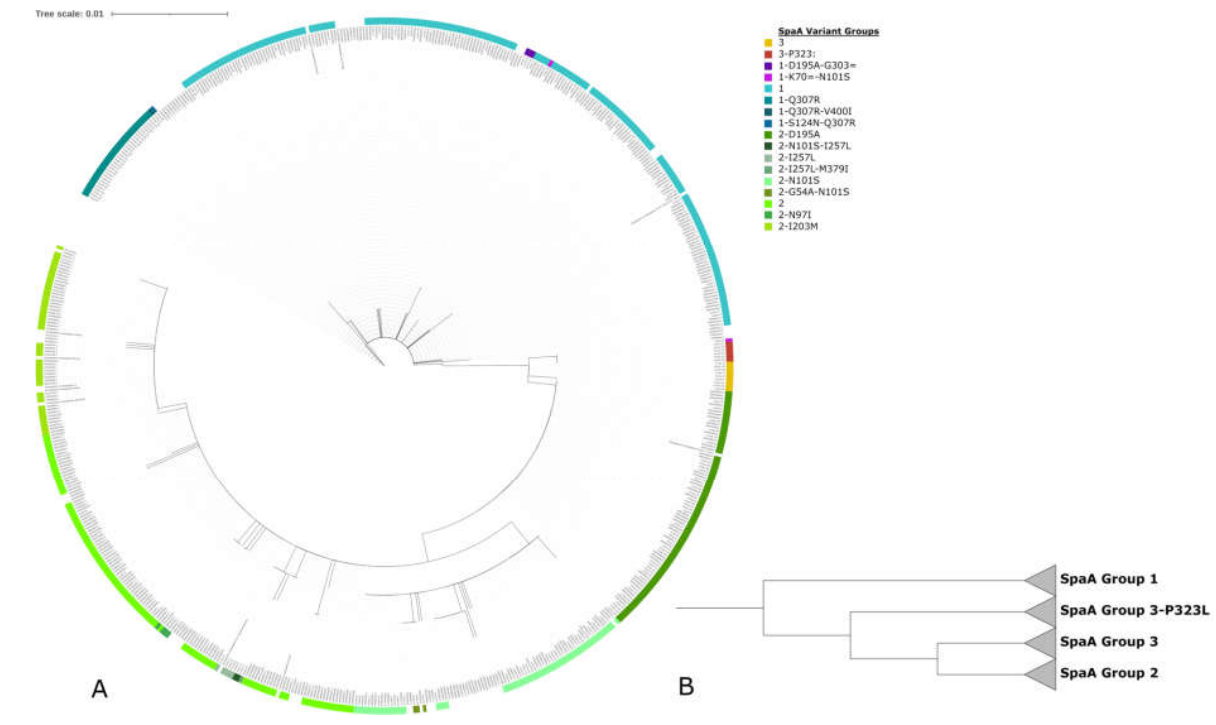
Figure 4. ( A ) RAxML maximum likelihood phylogeny of SpaA protein sequences over the hypervariable region from AA residues 30-413. ( B ) Collapsed branches ignoring branch length of the same SpaA tree showing the divergence of the groups 1, 2, 3 and 3-P323L.